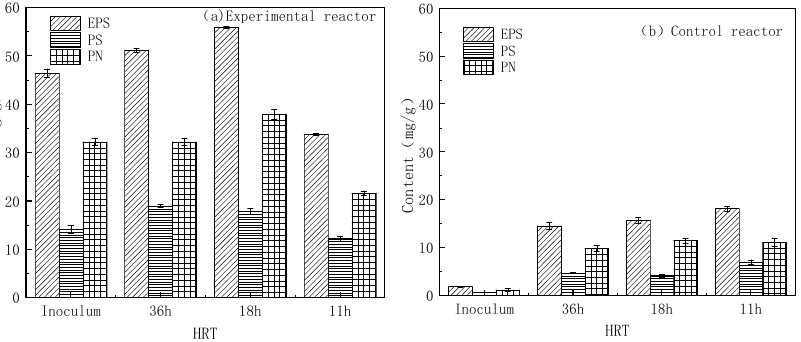
Figure 1. Contents of EPS and its components in biofloc from the two reactors under various HRTs.